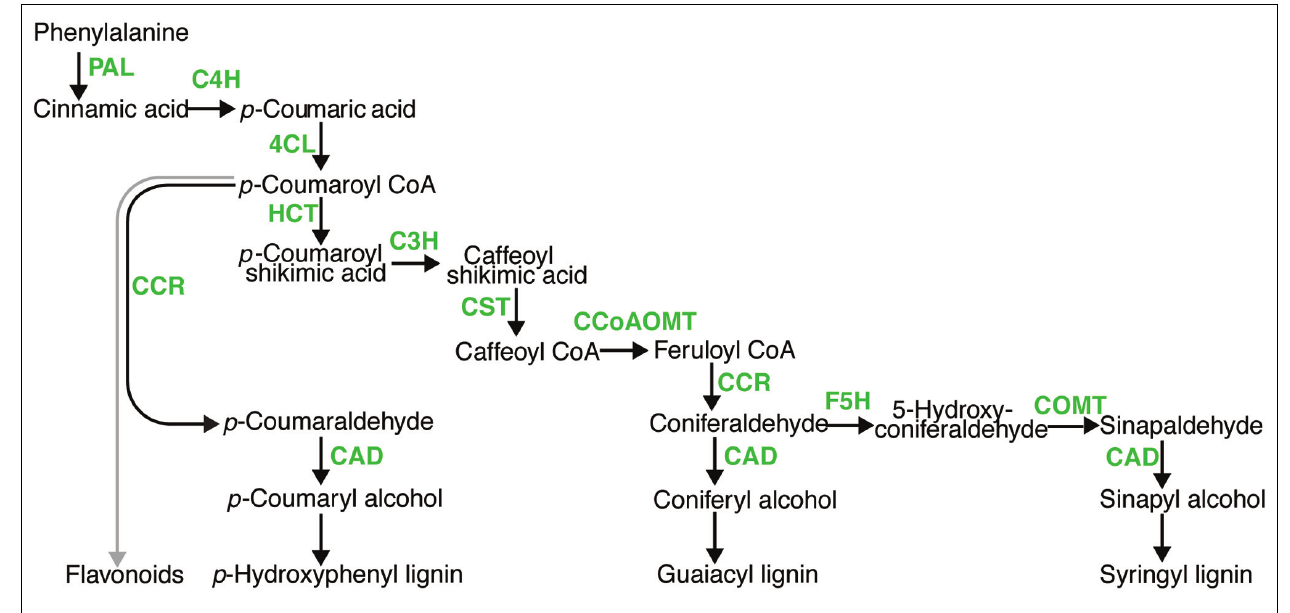
hydroxycinnamoyl CoA:shikimate transferase (HCT), p -coumarate 3-hydroxylase (C’3H), caffeoyl CoA O -methyltransferase (CCoAOMT), cinnamyl CoA reductase (CRR), ferulate 5-hydroxylase (F5H), caffeic acid O -methyltransferase (COMT), and cinnamyl alcohol dehydrogenase